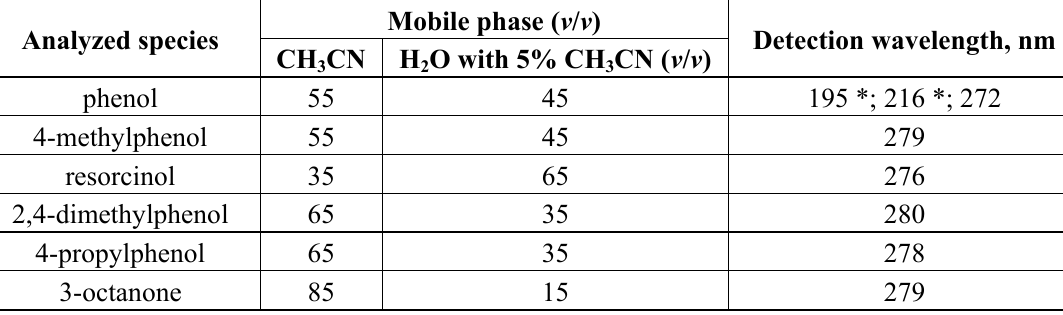
Table 5. Elution and detection conditions for the chromatographic